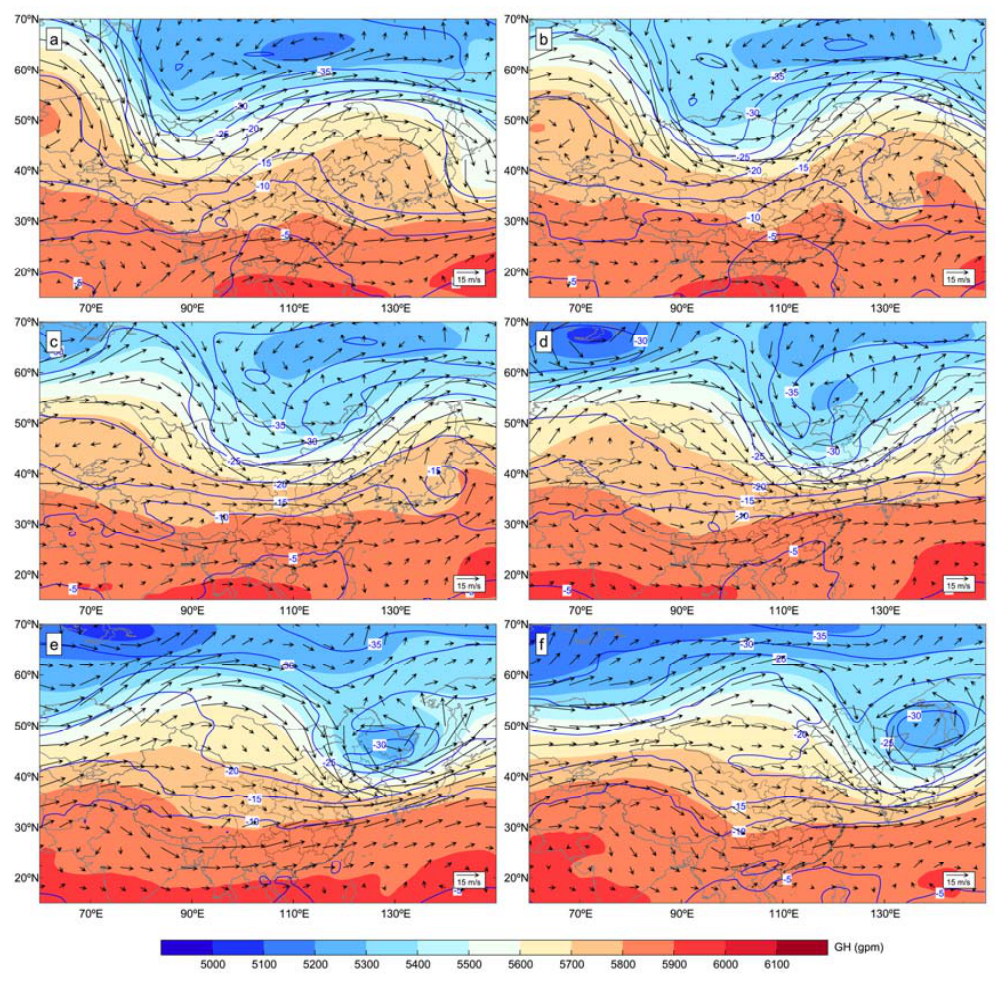
Figure 10. Spatiotemporal variation of the geopotential height ( shaded ), wind field and temperature ( contours ) at 500 hPa on 2–7 May 2017(sub-graph ( a – f ) respectively describe the geopotential height, wind field and temperature at 500 hPa on 2–7 May 2017).